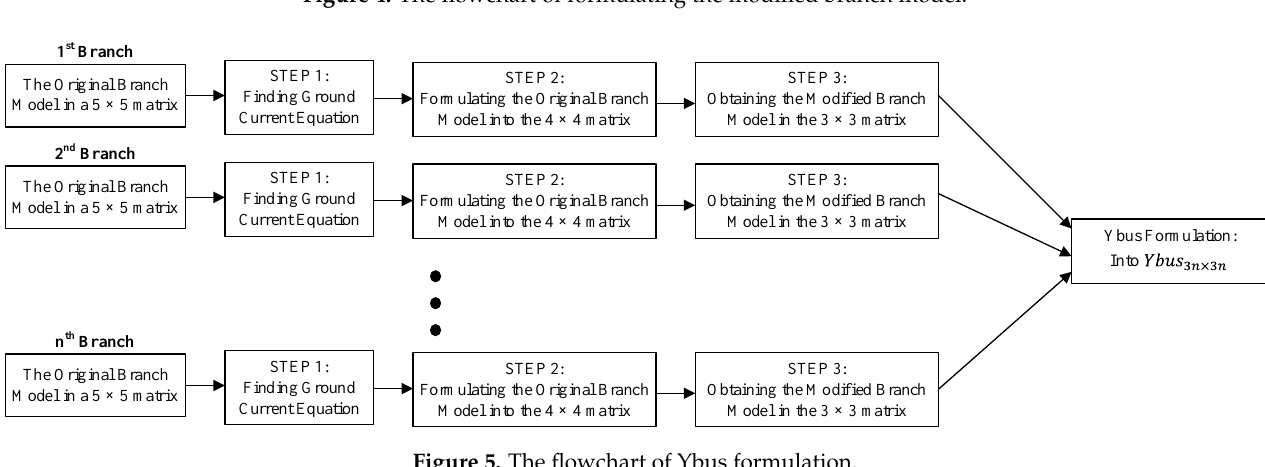
Figure 4. The flowchart of formulating the modified branch model.